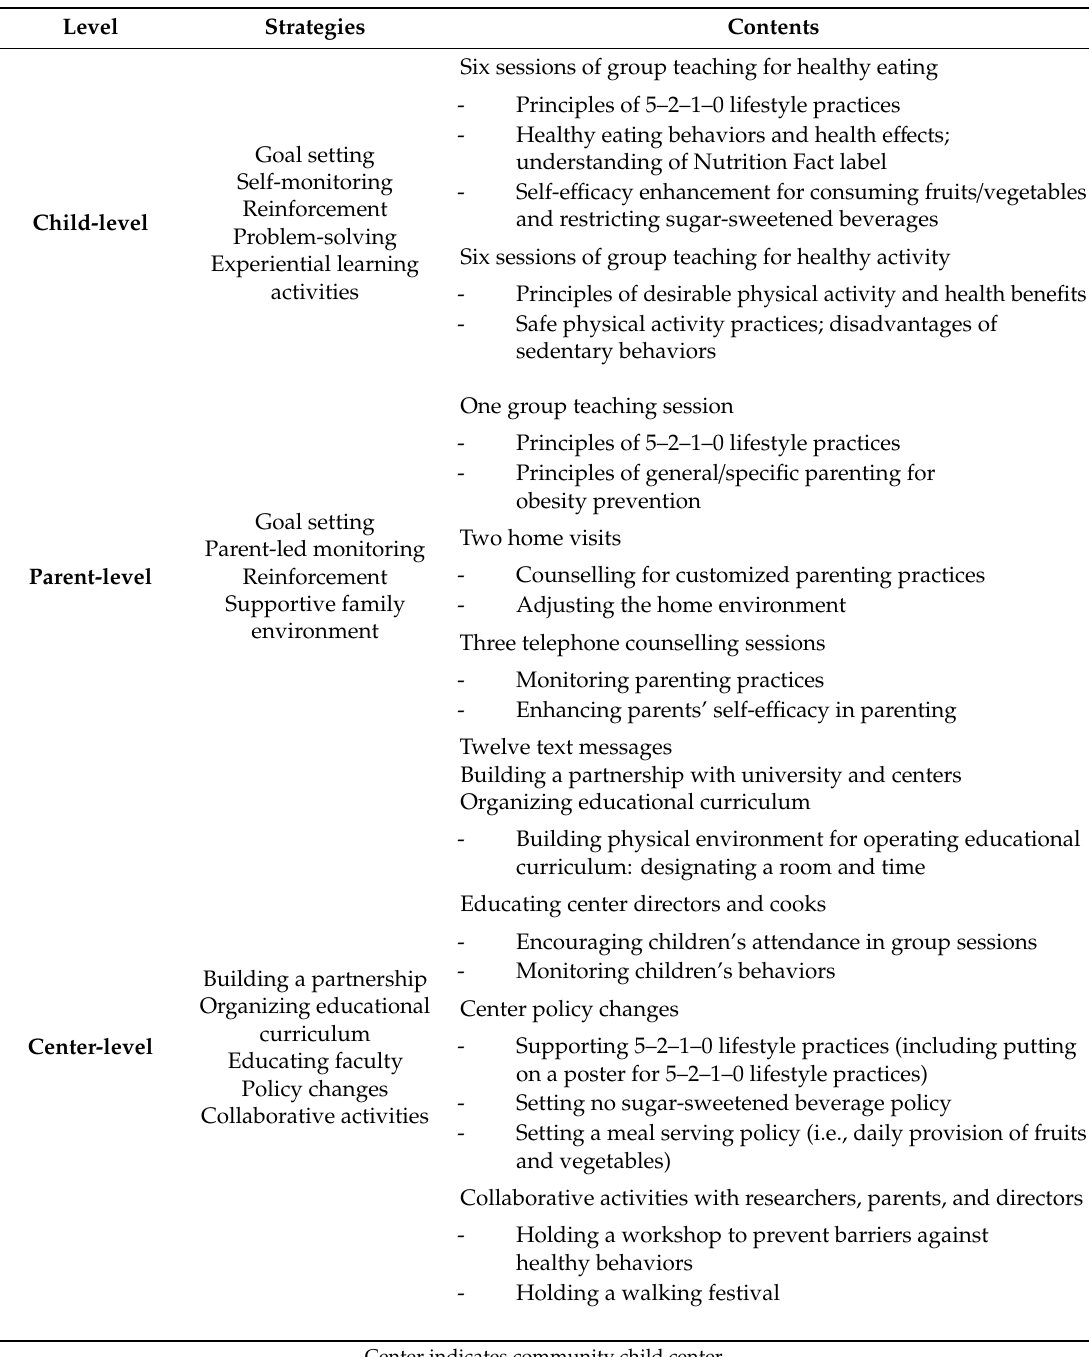
Table 1. The Three Healthy Program: multi-level intervention